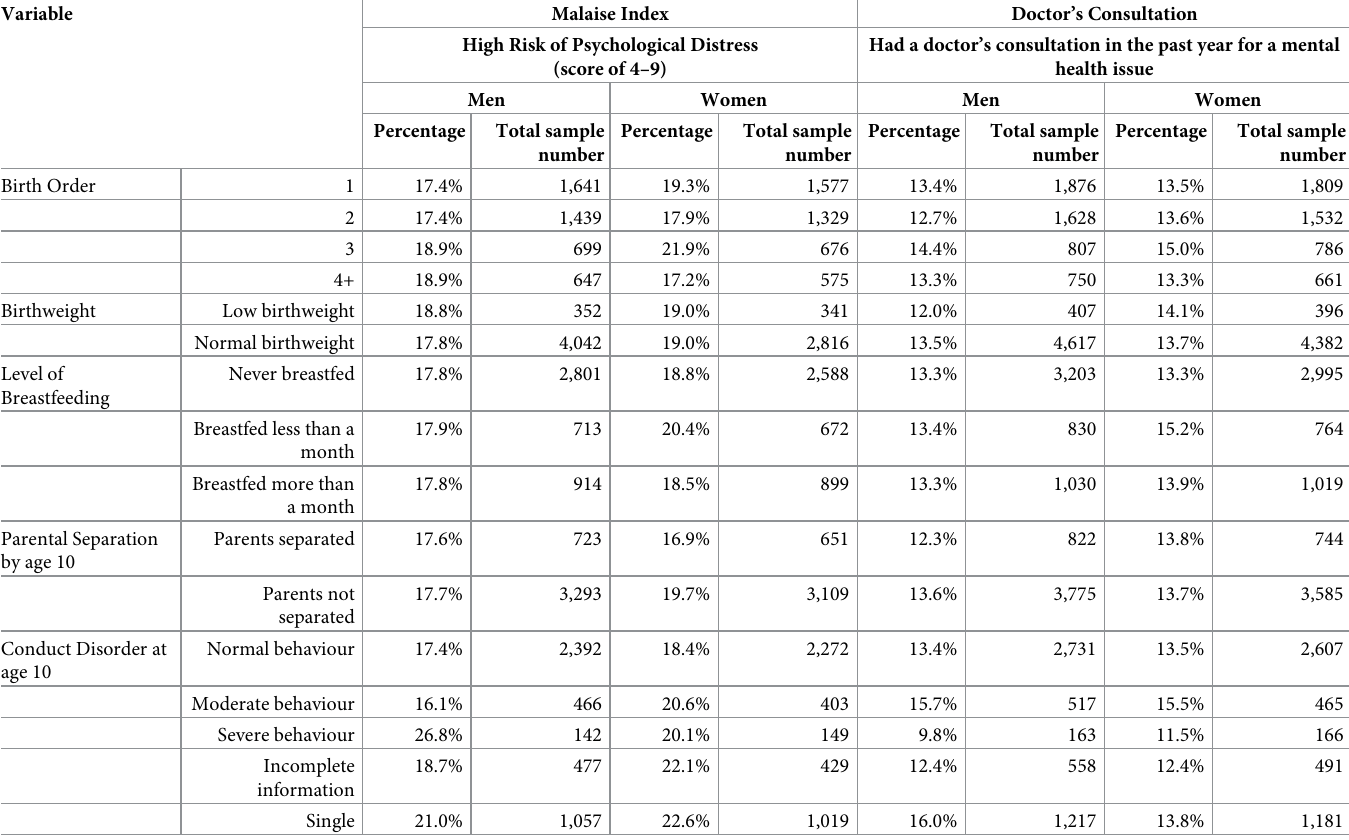
Table 1. Risk of malaise and whether consulted doctor about a mental health issue: Bivariate associations with birth order and childhood mediators. Variable